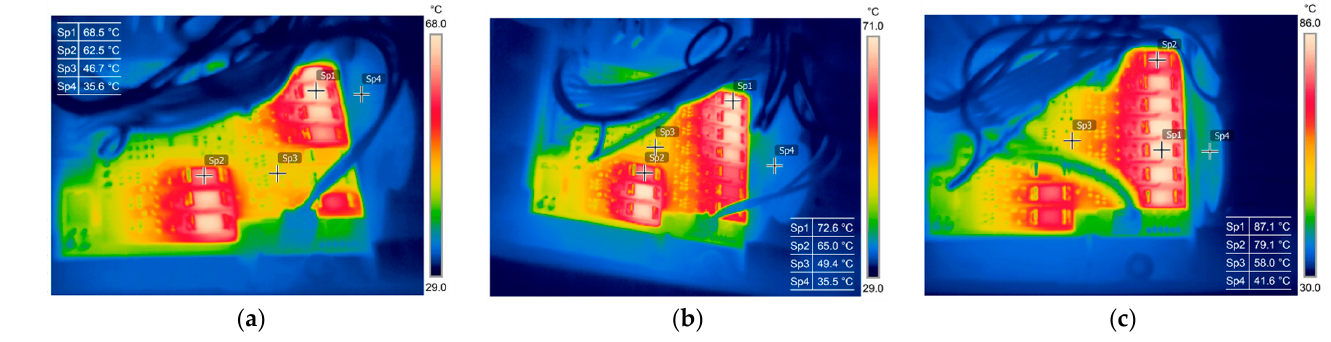
Figure 12. BMS thermal load during charging process at: ( a ) 1:45 PM; ( b ) 1:58 PM; ( c ) 2:05 PM.